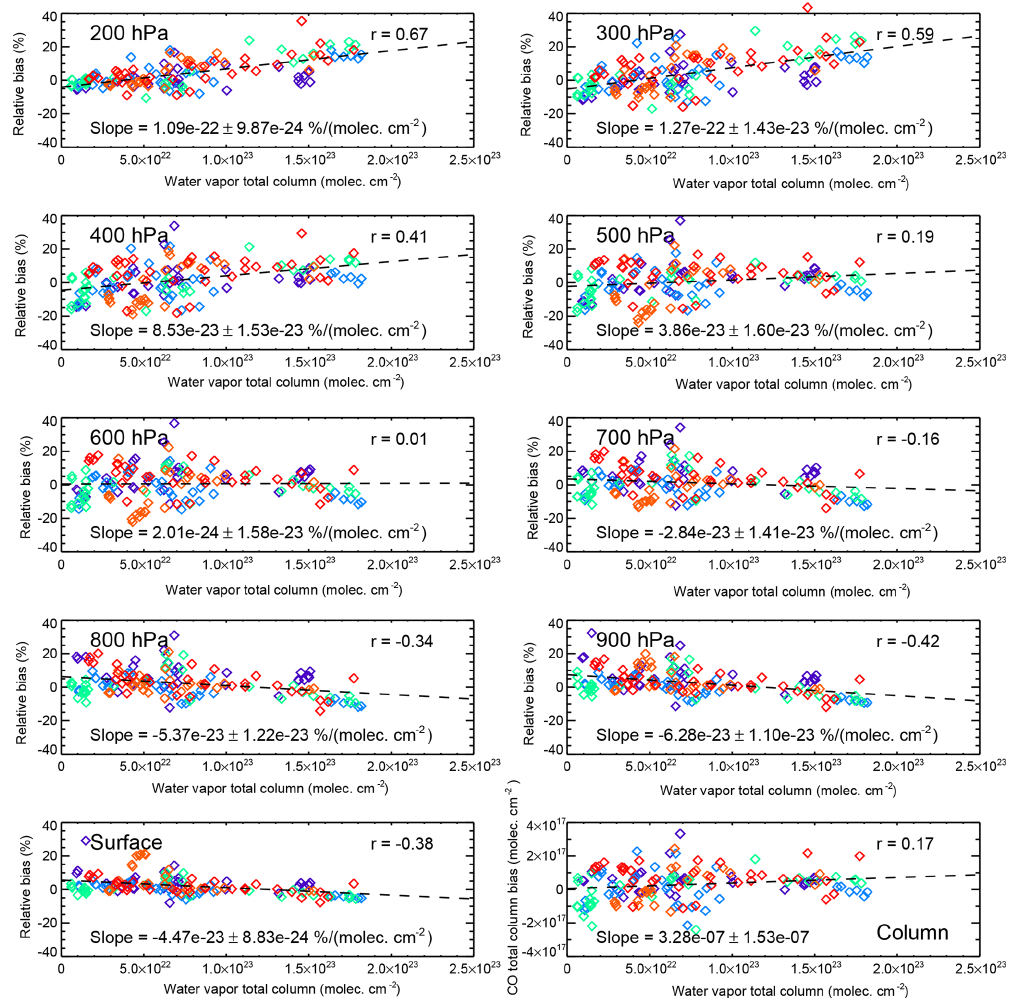
Figure 3. Dependence of V7 TIR-only biases on water vapor total column, based on the HIPPO CO profiles. Colors indicate the particular phase of the HIPPO mission, as described in the caption to Fig.